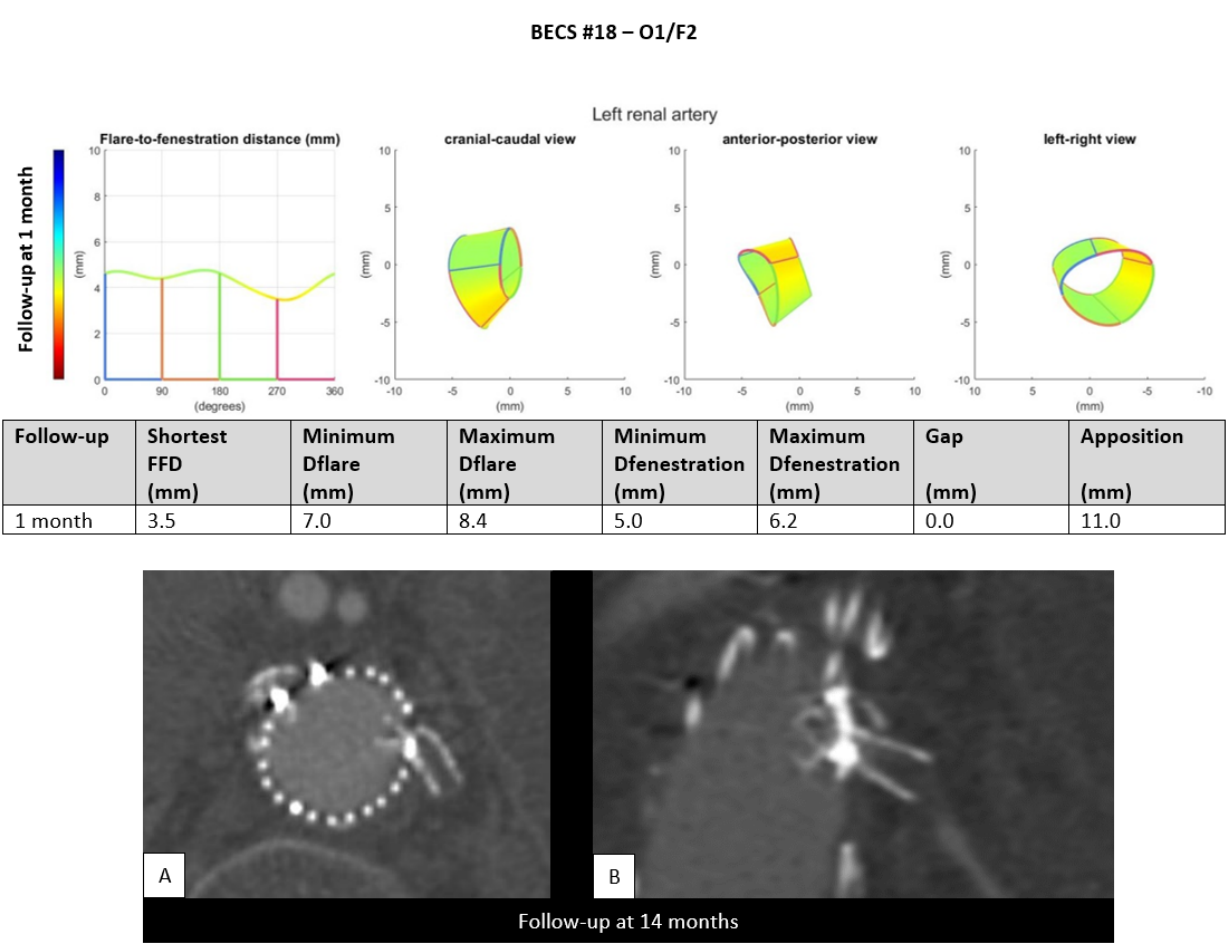
Figure 7. BECS #18 is an example of O1, combined with F2, obstruction due to flare compression and fracture of multiple struts. Geometric analysis of the 1 ‐ month post ‐ FEVAR CTA scan shows a good flare with adequate diameters. The 14 ‐ months post ‐ FEVAR CTA scan (( A ); axial view of the aorta, ( B ); stretched vessel view of the aorta) showed a compressed and fractured BECS in the left renal artery.